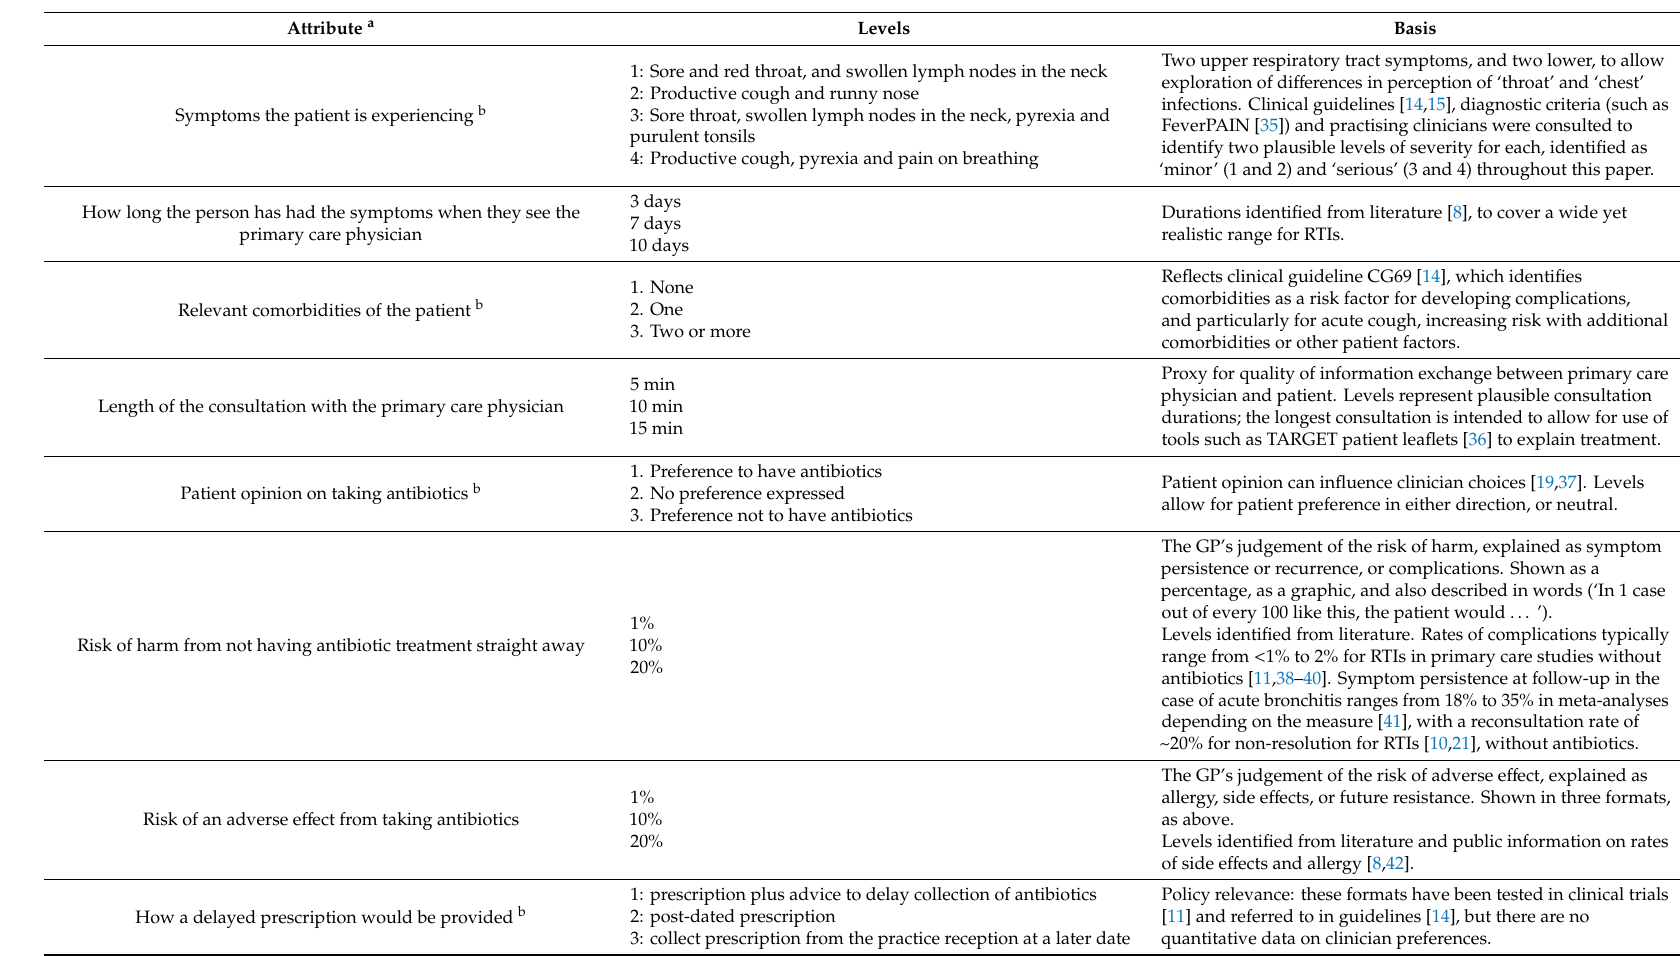
Table 1. Attributes and levels for the choice